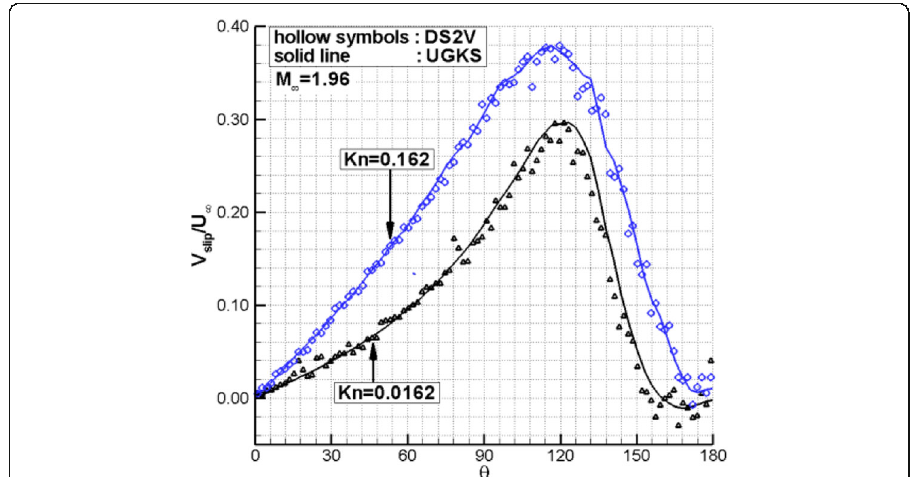
Fig. 13 Slip velocity distributions on the cylinder surface at M = 1.96